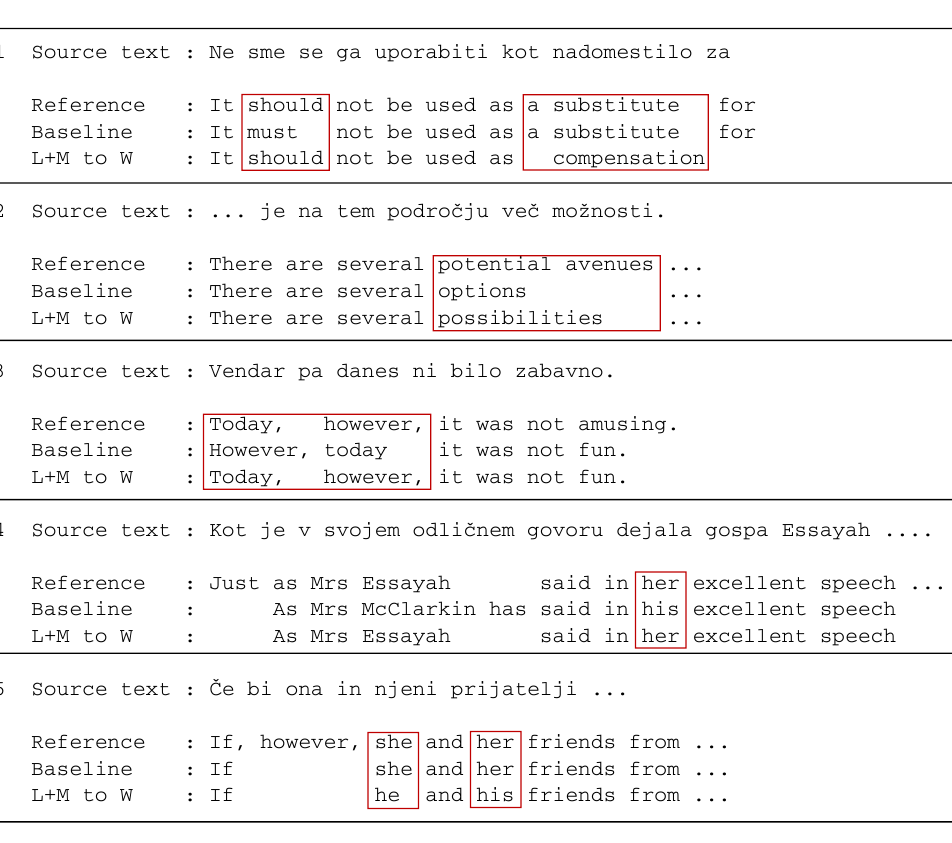
Figure 5. Selected translation examples from Slovene to English with the source text, reference translation, baseline system translation and improved system translation using lemmas and MSD tags (L+M to